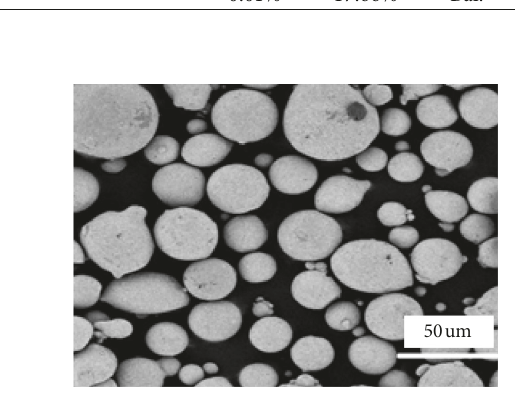
Figure 1: Powder of 316L.